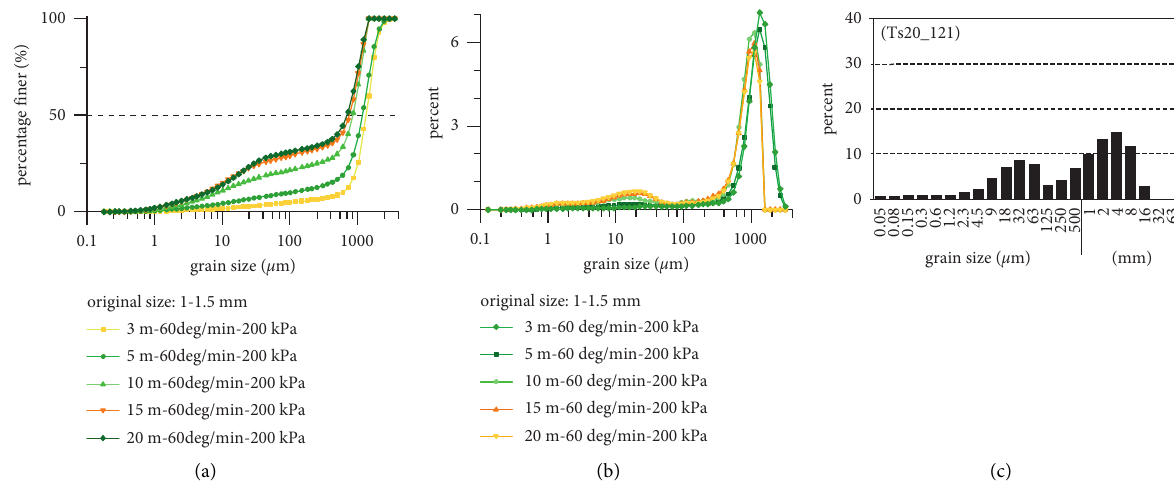
Figure 7: Evolution of grain size distributions with shearing displacements. (a) Cumulative grain-size distribution curves at a shear rate of 60deg/min under a normal stress of 200kPa after shearing at 3m, 5m, 10m, 15m, and 20 m. (b) Frequency grain-size distribution curves at a shear rate of 60deg/min under a normal stress of 200 kPa after shearing at 3m, 5 m, 10m, 15m, and 20m. (c) Grain-size distribution histograms of the shear zone at Tschirgant showed bimodal distributions [30]. Table 3: Fractal dimensions of the different